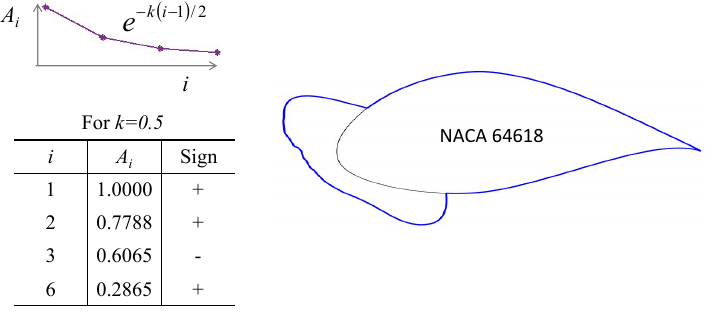
Figure 3. Parameters used for an ice shape creation on a NACA 64618 aerofoil section used in the NREL 5 MW wind turbine blade.